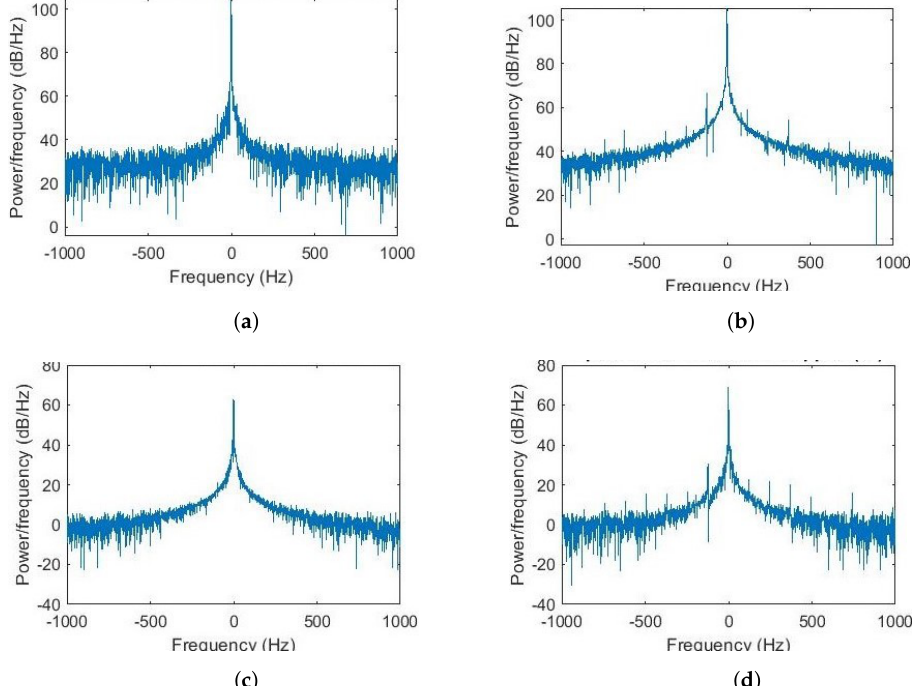
Figure 4. ( a ) Spectral density of single tone without Doppler. ( b ) Spectral density of single tone with Doppler. ( c ) Spectral density of BPSK without Doppler ( x 2 ). ( d ) Spectral density of BPSK with Doppler ( x 2